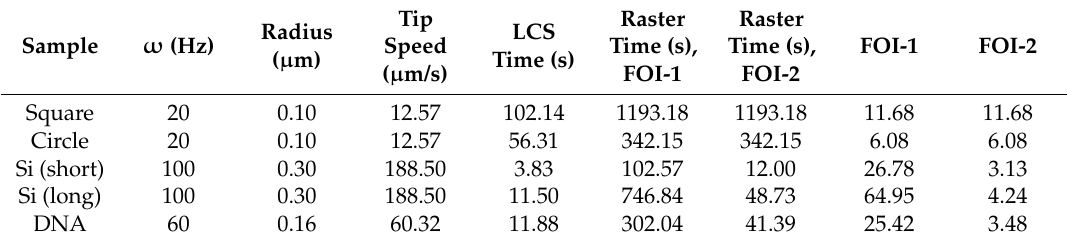
Table 1. Selection of results for calibration gratings, silicon step and λ -DNA. LCS times were experimentally determined; raster times were calculated based on tip speed and image dimensions